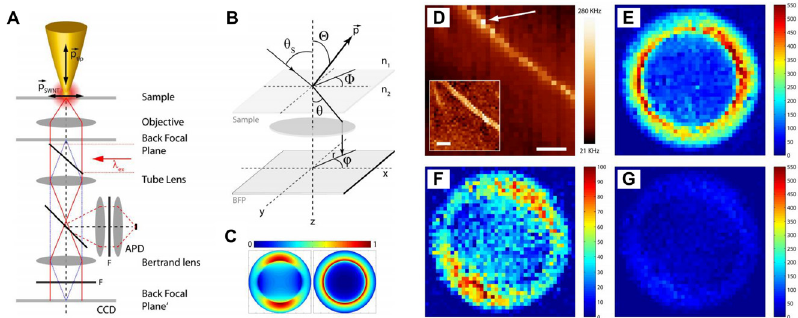
Figure 9: (A) Schematicdiagram of near-field PL measurement setup. (B) Modeling of the detectionbeampathtoanalyzePLradiation pattern.(C)Simulatedradiationpatternsfor the two different point dipole conditions, i. e., horizontally oriented ( θ = 90 ° ) and vertically oriented ( θ = 0 ° ) dipoles. (D) TEPL image and topography of the SWCNT. The scale bar is 100 nm. Tip-enhanced near- fi eld (E) and far- fi eld (F, G) PL radiation patterns at the point indicated by an arrow in TEPL image (D). (G) is the same image as (F), but the intensity scale is modi fi ed for